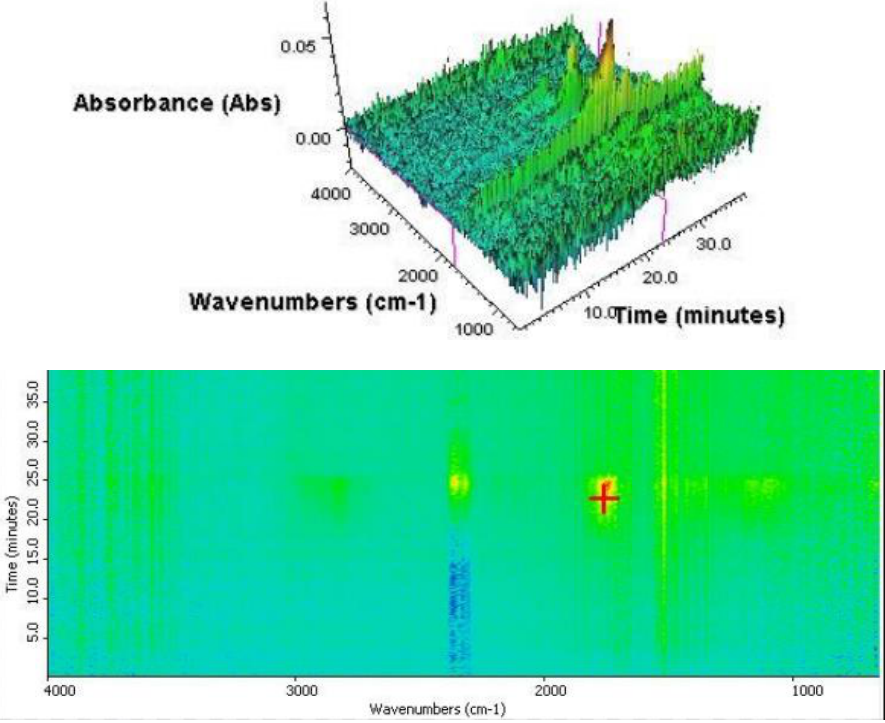
Figure 6. TGA analysis of the impregnated wooden tie sample.